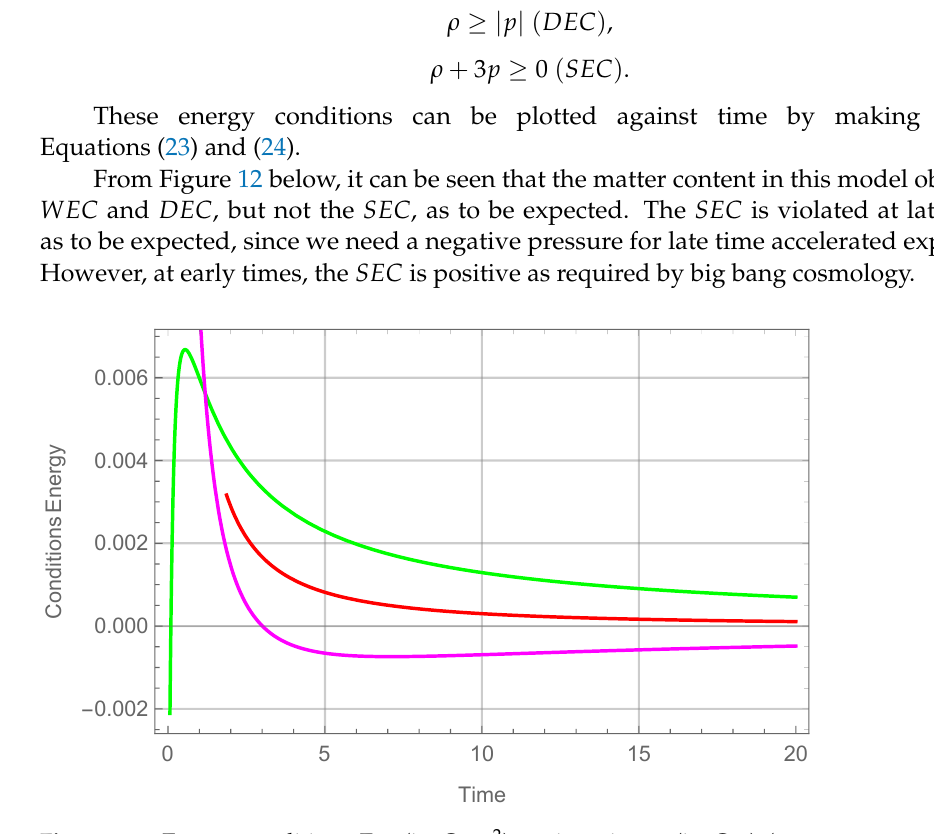
Figure 12. Energy conditions Ecs (in Gyr − 2 ) against time t (in Gyr ) (green: ρ − p ; red : ρ + p ; magenta : ρ + 3 p